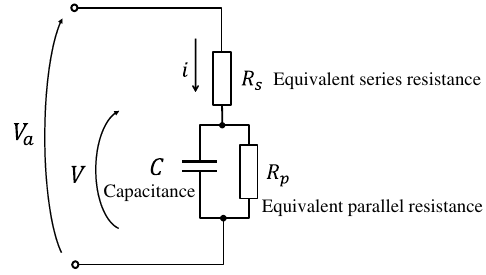
Figure 7. Electrical impedance model of a